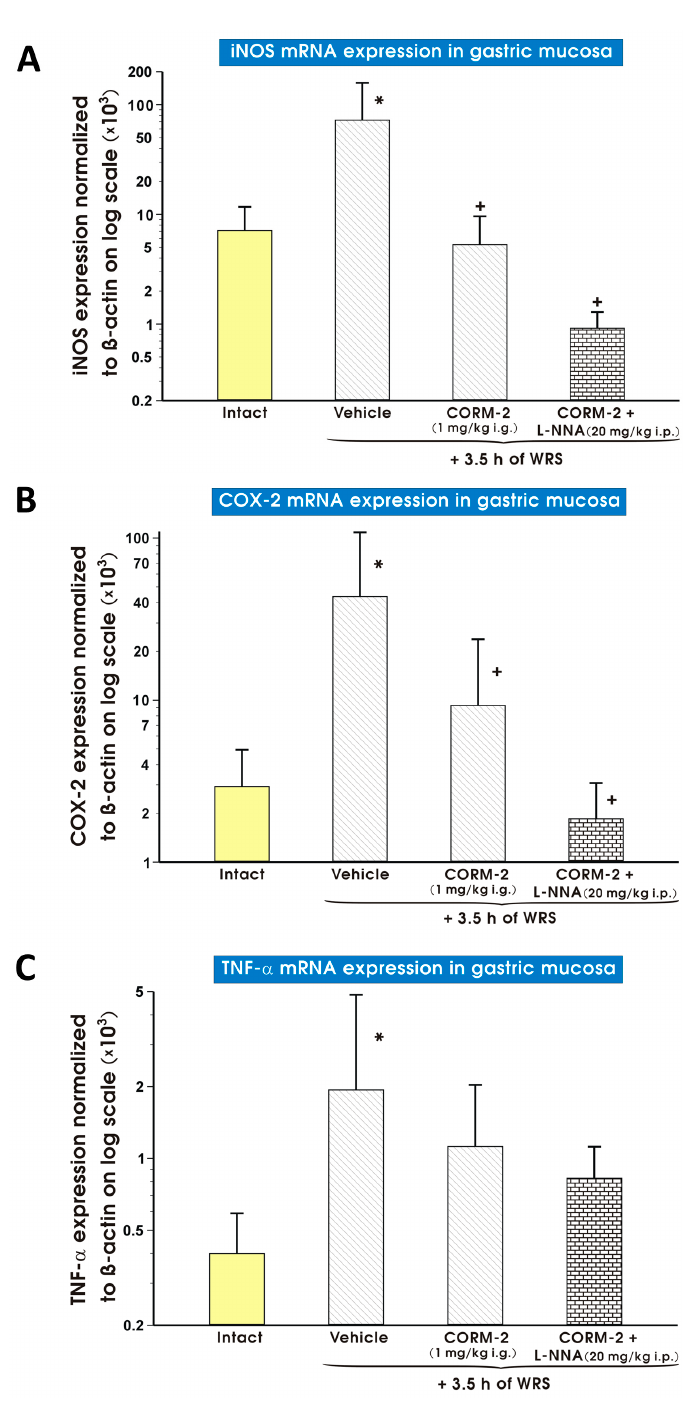
Figure 11. Expression levels of mRNA for inducible nitric oxide synthase (iNOS) ( A ); cyclooxygenase 2 (COX-2) ( B ); or tumor necrosis factor α (TNF- α ) ( C ) in the gastric mucosa of intact rats (yellow pattern) or those pretreated with vehicle (saline; i.g.; line pattern), carbon monoxide releasing molecule 2 (CORM-2, 1 mg/kg i.g.; line pattern) alone or in combination with N G -nitro- L -arginine ( L -NNA, 20 mg/kg i.p.; brick pattern) in rats 30 min later exposed to 3.5 h of water immersion and restraint stress (WRS). Results are expressed as mRNA expression of iNOS, COX-2 and TNF- α normalized to β -actin. Results are mean ± S.D. of 6–8 determinations per group. Asterisk indicates a significant change ( p < 0.05) as compared with the respective values in intact gastric mucosa. Cross indicates significant change ( p < 0.05) as compared with the values obtained vehicle-treated group.